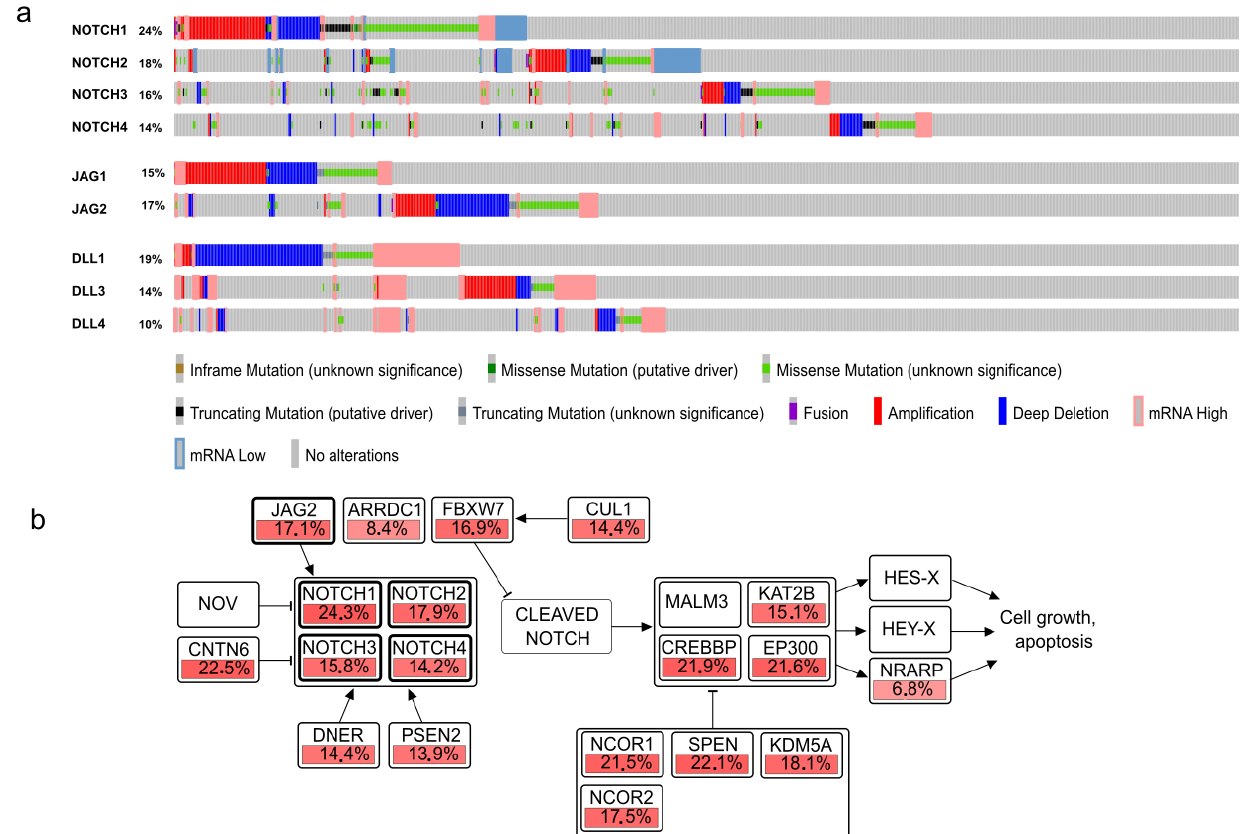
Figure 1. Genetic alterations in Notch pathway genes across human cancer cell lines. ( a ) Mutual exclusivity of genetic events targeting NOTCH receptors and ligands across 1000+ cell lines from the Cancer Cell Line Encyclopedia (CCLE) collection, as displayed in the cBioPortal genome browser. The sorting by mutation type illustrates that genetic mutations affect typically only one of the four NOTCH receptors. Similar mutual exclusivity is observed for the JAG1 and 2, and DLL1, DLL3, and DLL4 ligands. ( b ) Percentage of genetic events (mutations, amplifications, deletions, over-expression) observed in core genes of the Notch pathway, across the 1000+ cell lines of the CCLE collection/BROAD Institute (https://www.cbioportal.org/study?id=ccle_broad_2019). Gene Symbols as identifiers used according to Genome Reference Consortium Human Build 37 (GRCh37).